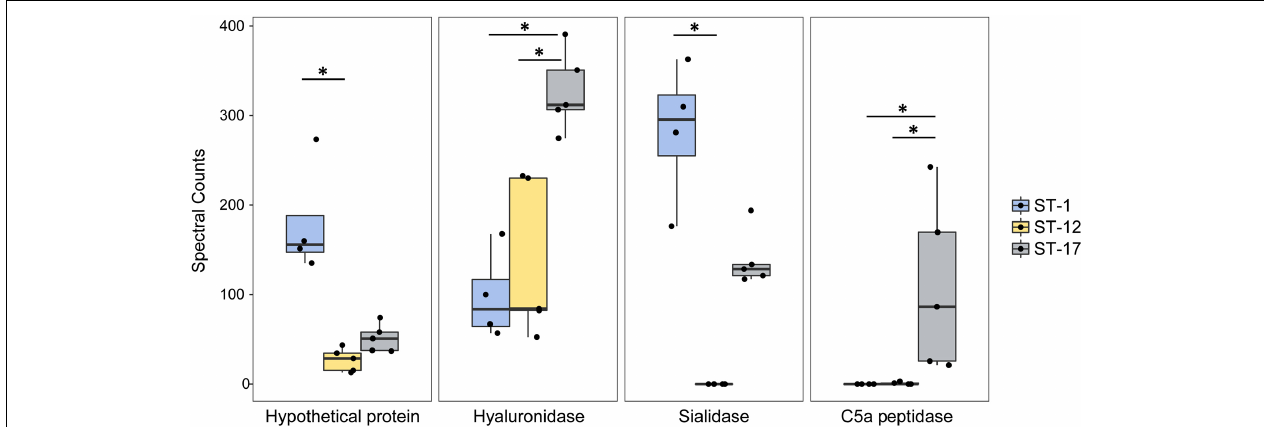
FIGURE 8 | Highly abundant proteins are present at variable levels in group B streptococcal membrane vesicles (MVs). The spectral counts of specific proteins were plotted after stratifying by the sequence type (ST). The median spectral count associated with each ST is represented within each box. The black dots represent a single biological replicate for a given strain. Statistical comparison was performed using a Kruskal Wallis test. Multiple pairwise comparisons were then made using the pairw.kw function in R, which uses a conservative Bonferroni correction method to correct for multiple hypothesis testing. Comparisons with p -values < 0.05 are denoted with an